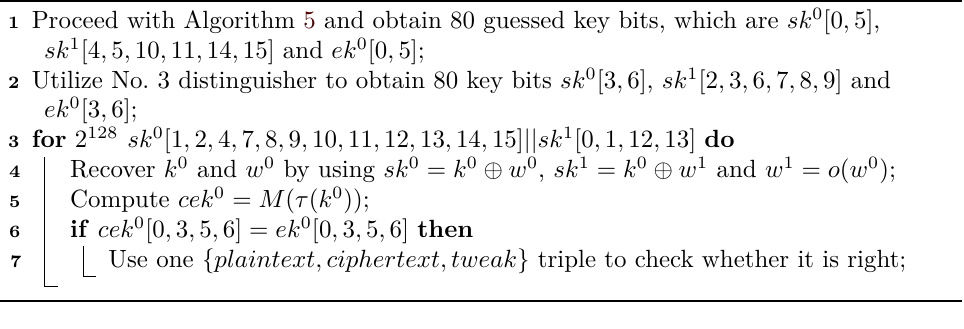
Algorithm 4: Key Recovery Procedure of 11-Round QARMA -128